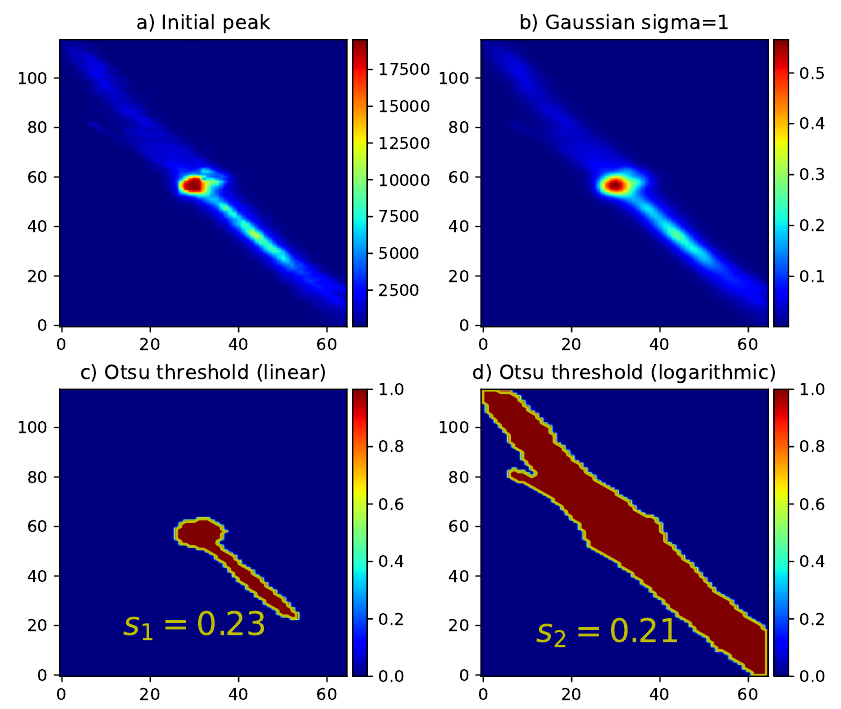
Figure A10. Example of a peak region ( a ) after first peak finding (initial cutout), ( b ) after Gaussian blurring with 1 s.d. = 1 pixel, ( c ) after Otsu thresholding and its corresponding sphericity in linear intensity scale ( s 1 = 0.23) and ( d ) after Otsu thresholding and its corresponding sphericity ( s 2 = 0.21) in logarithmic intensity